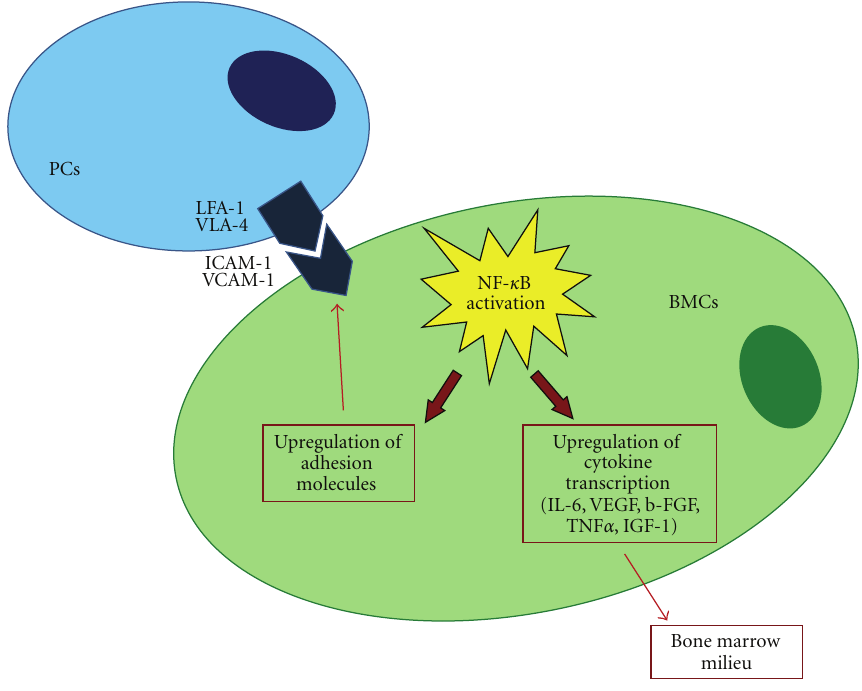
Figure 3: NF-kB activation and its functional biological sequelae.